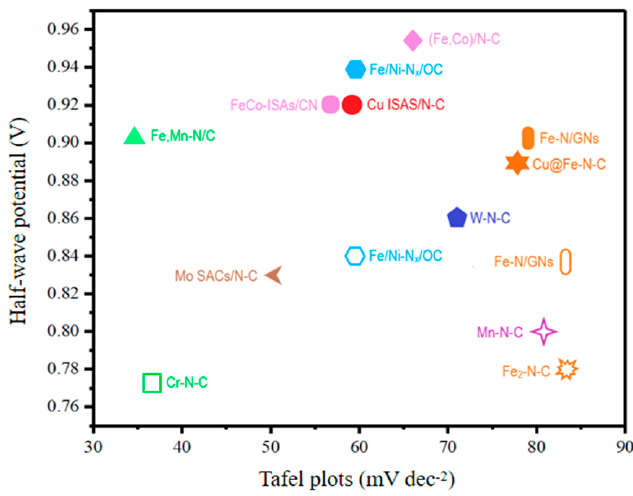
Figure 7. The comparison of ORR performances of M SAC -N-C catalysts derived from ZIF-8 (solid points express the performance in alkaline electrolyte, hollow points express the performance in acidic electrolyte). (Fe-N/GNs [69], Mn-N-C [76], Cr-N-C [77], W-N-C [78], Mo SACs/N-C [74], Cu ISAS/N-C [79], Fe 2 -N-C [42], Cu@Fe-N-C [80], (Fe,Co)/N-C [81], FeCo-ISAs/CN [82], Fe/Ni-N x /OC [83], Fe,Mn-N/C